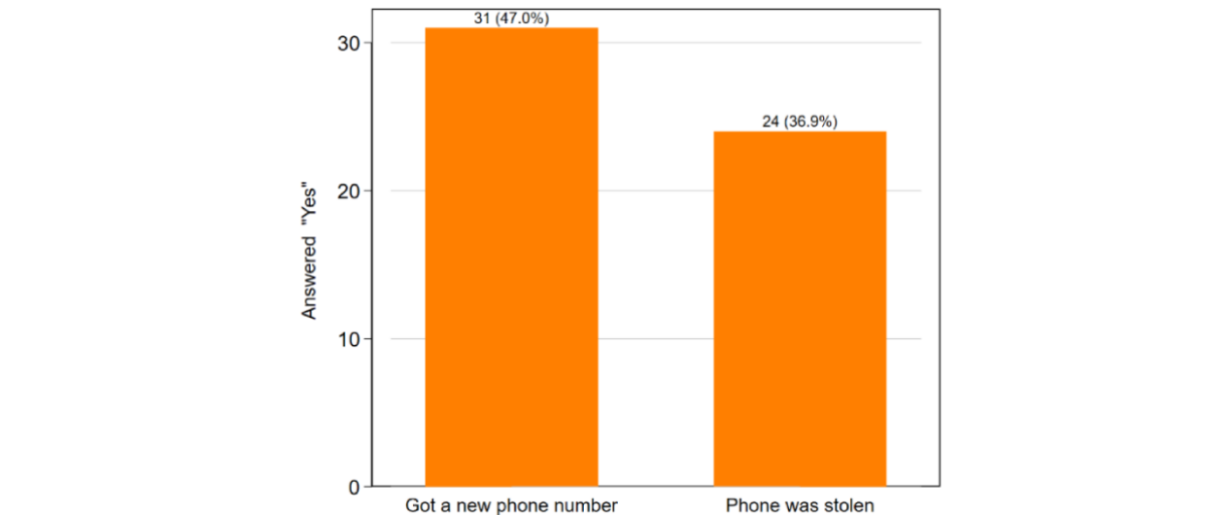
Figure 2. Cell phone and number retention at follow-up